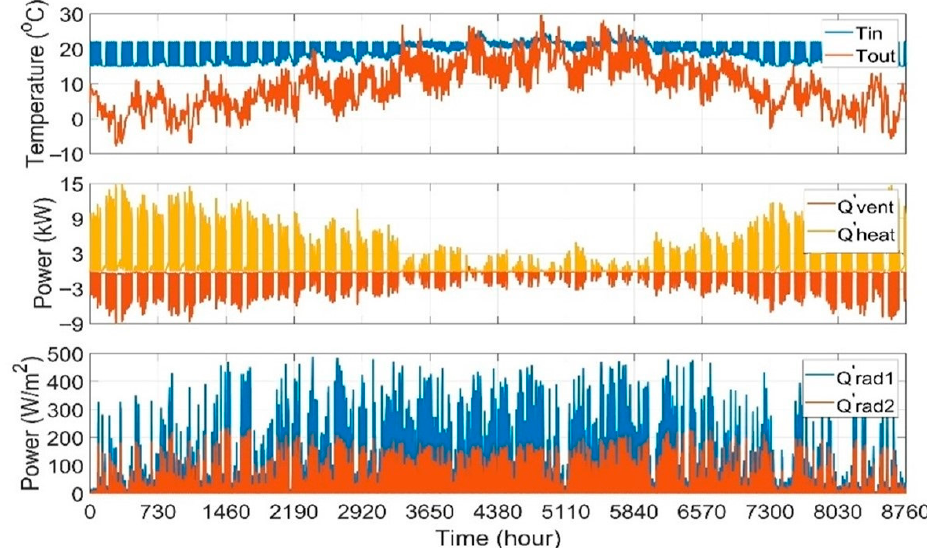
Figure 4. Indoor and outdoor temperature, heat production, heat losses through ventilation, and solar radiation gains for a 100 m 2 , south-faced, heavy-structured building with WF equal to 15% simulated in TRNSYS.